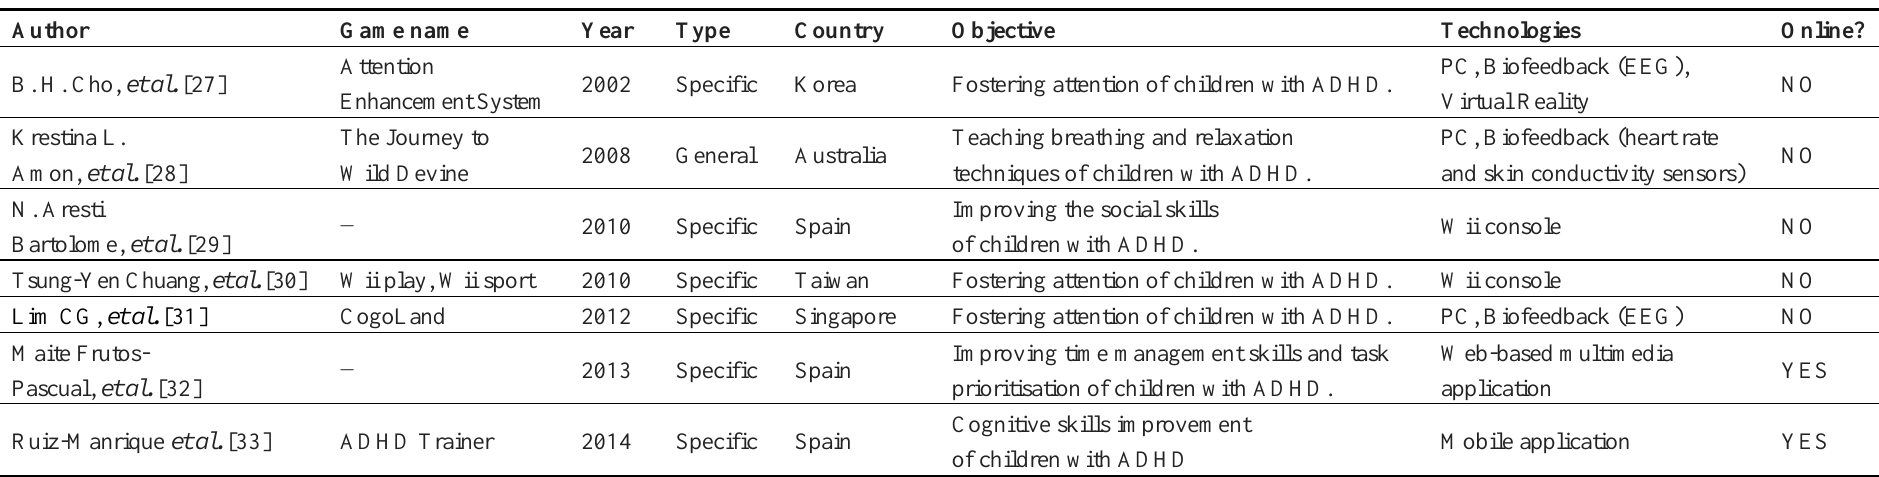
Table 2. Specific applications for children with